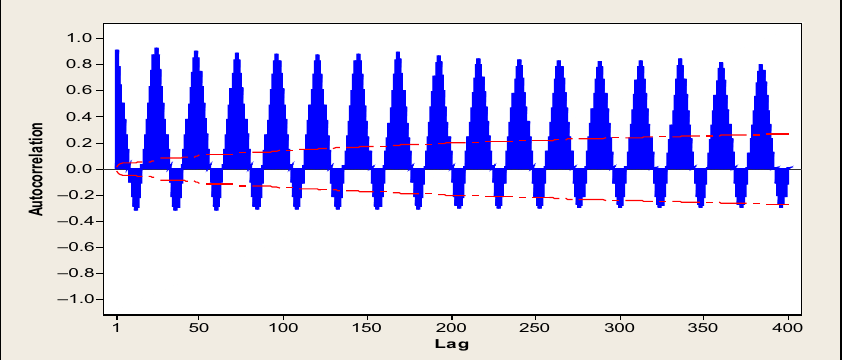
Figure 2. ACF of the